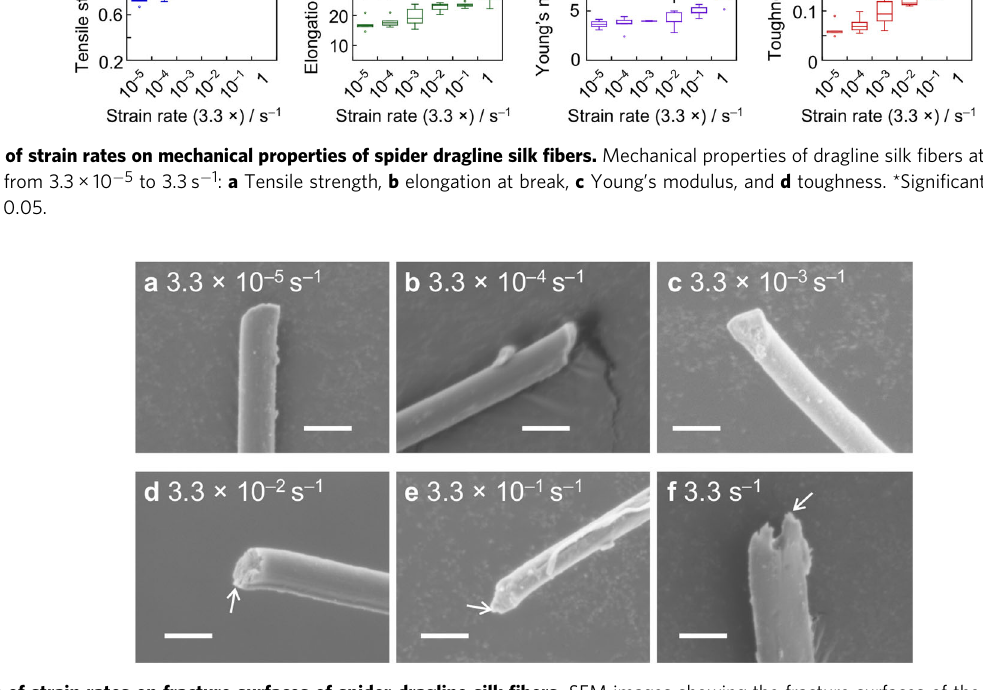
Fig. 3 Effects of strain rates on fracture surfaces of spider dragline silk fi bers. SEM images showing the fracture surfaces of the dragline silk fi bers at RH43% under different strain rates: a 3.3 × 10 − 5 s − 1 , b 3.3 × 10 − 4 s − 1 , c 3.3 × 10 − 3 s − 1 , d 3.3 × 10 − 2 s − 1 , e 3.3 × 10 − 1 s − 1 , and f 3.3 s − 1 . Each scale bar denotes 5 µ m. Arrows in ( d ) to ( f ) represent the broken fi brils in the fracture